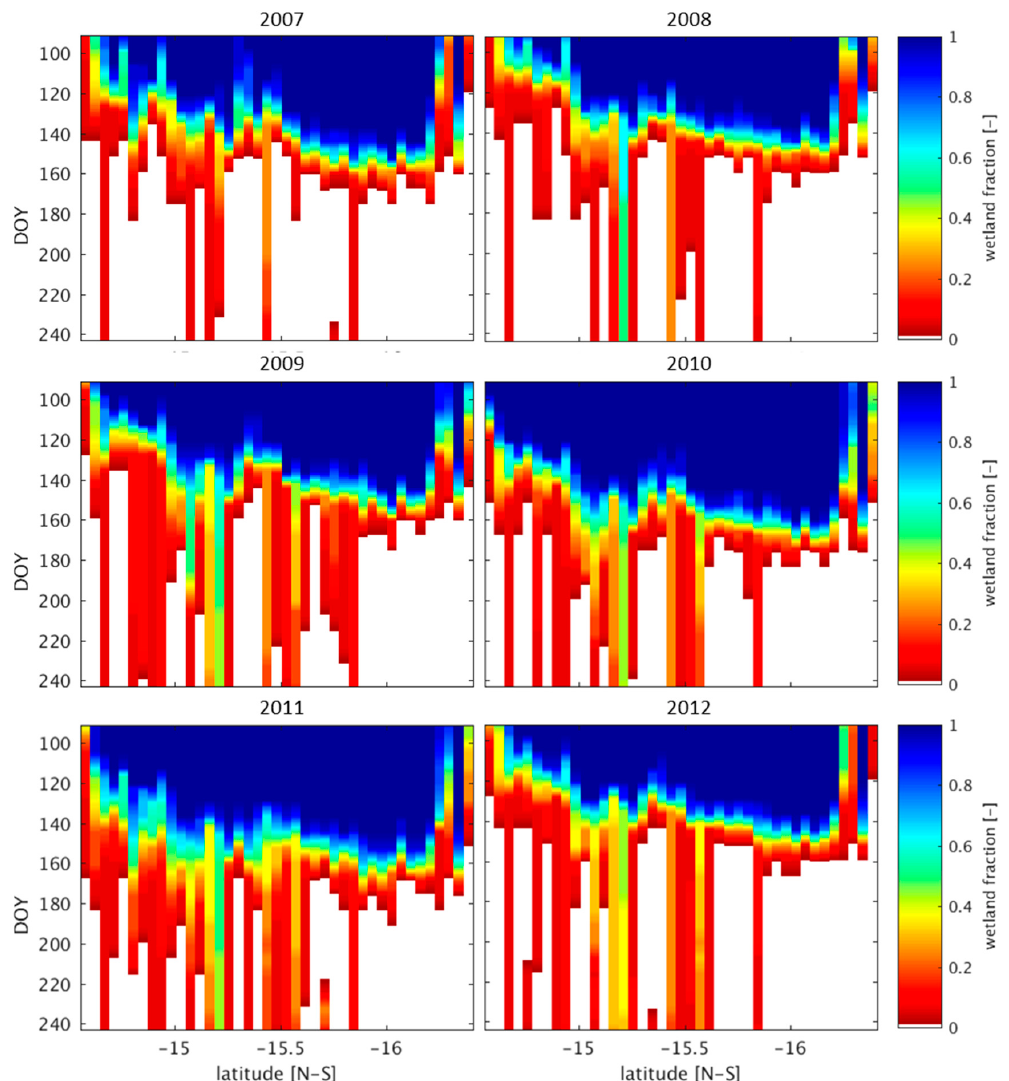
Figure 11. Wetland persistence in wet years. These plots show the maximum wetland fraction along a transect located between 22.7° and 24° longitude. The subset area is displayed in Figure S1. In years 2007–2012 many wetland areas continue to exist after the end of May (approximately day 150), specifically between − 15° and − 15.5° latitude. Hövemöeller diagrams of rainfall in wet years over the same region are presented in Figure S4.